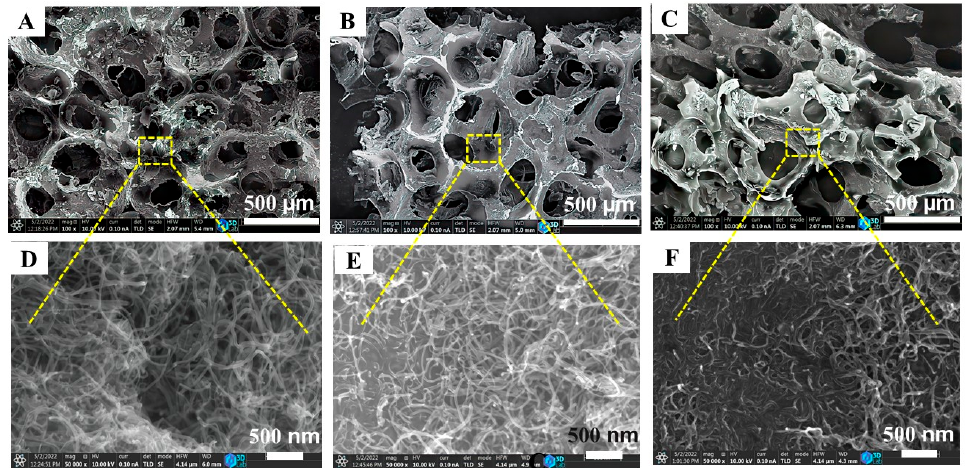
Figure 6. SEM images of the prepared N-BCNT/PU sensors, sample 1 ( A , D ), sample 2 ( B , E ), and sample 3 ( C , F ).